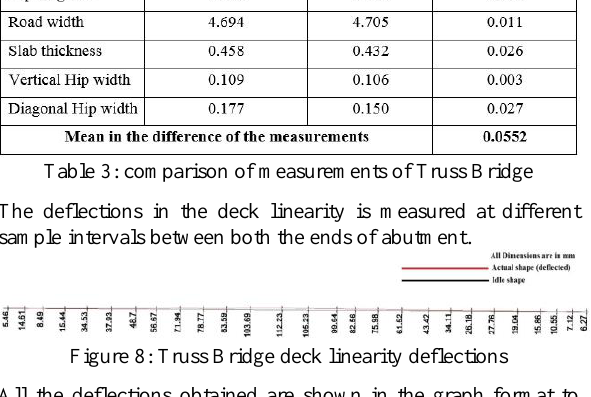
Figure 11: Side drawing of Beam Bridge